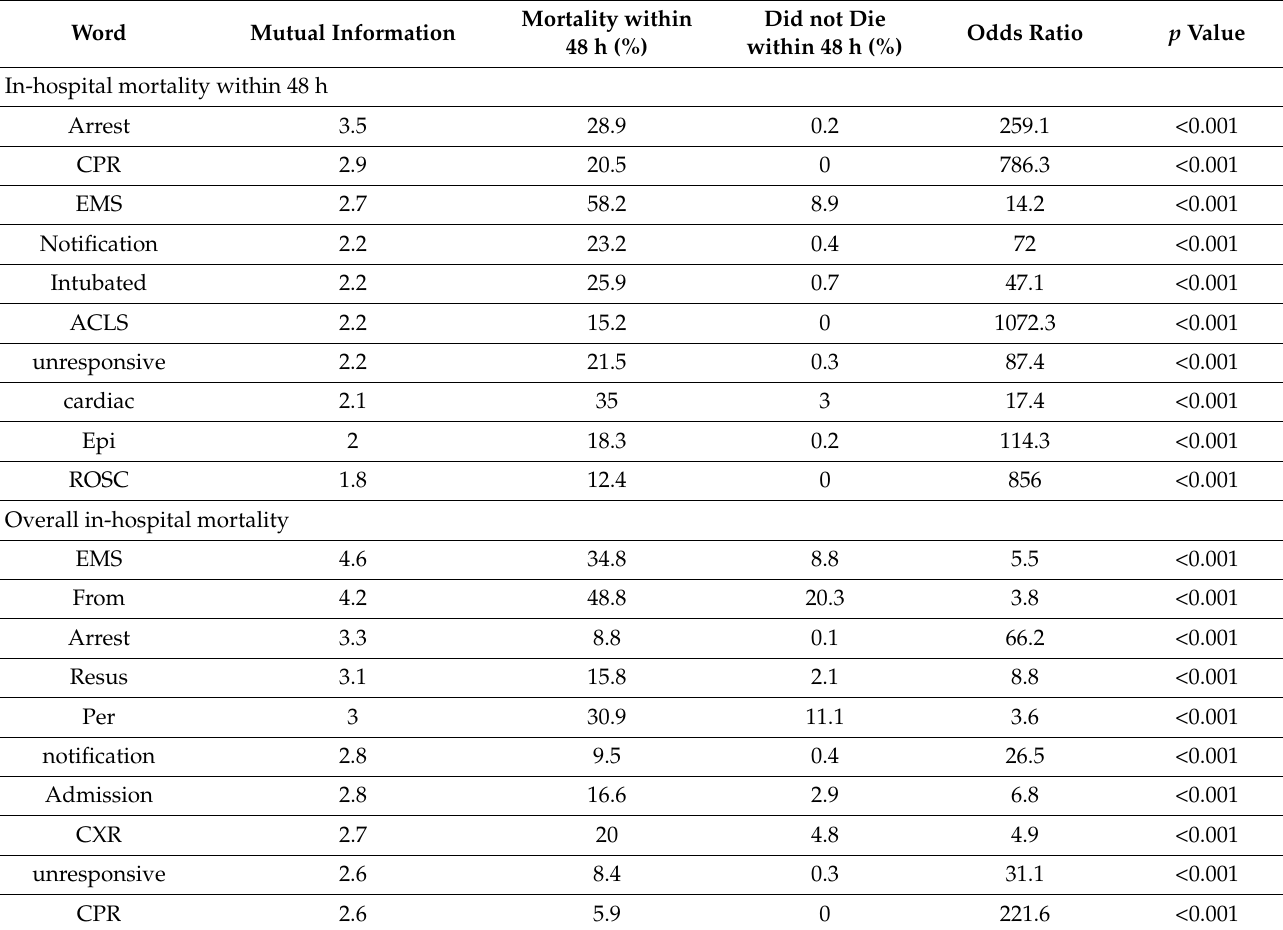
Table A2. Words associated with in-hospital mortality within 48 h and overall in-hospital mortality.